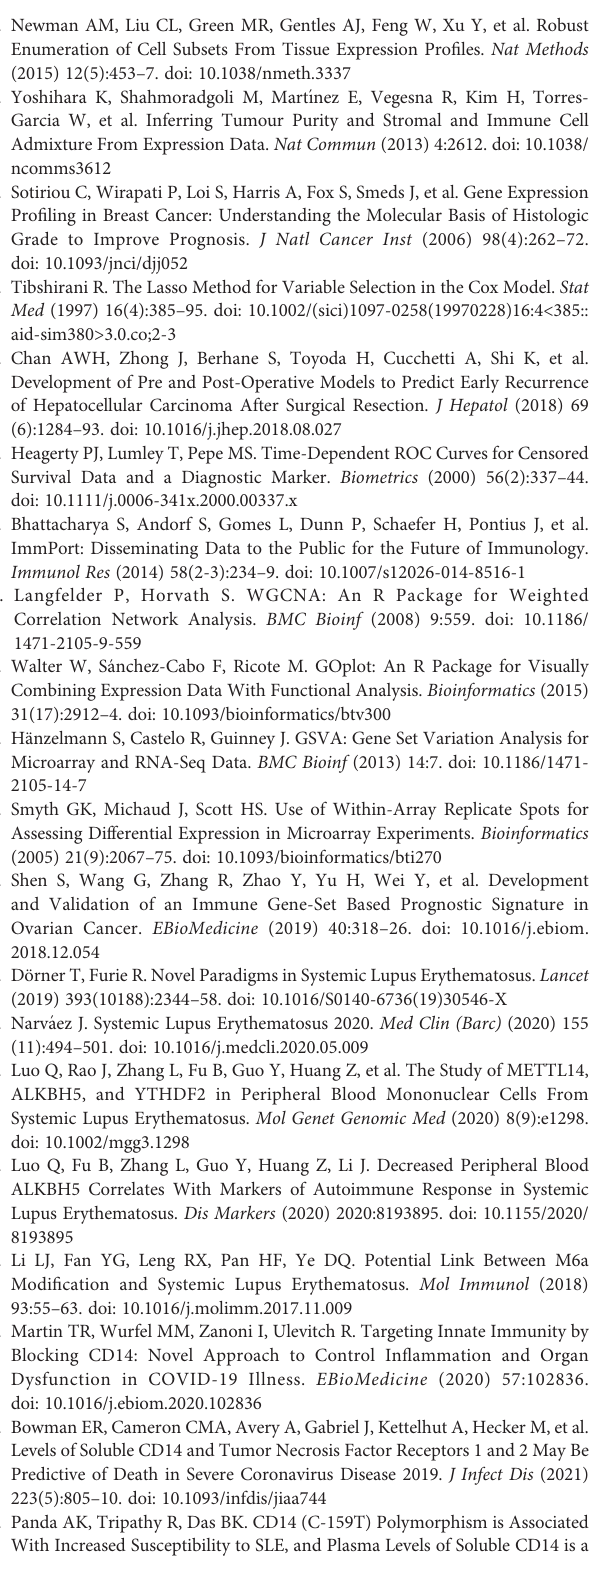
Supplementary Table 11 | Datas of the gene expression of GSE39088. Supplementary Table 12 | Datas of the gene expression of